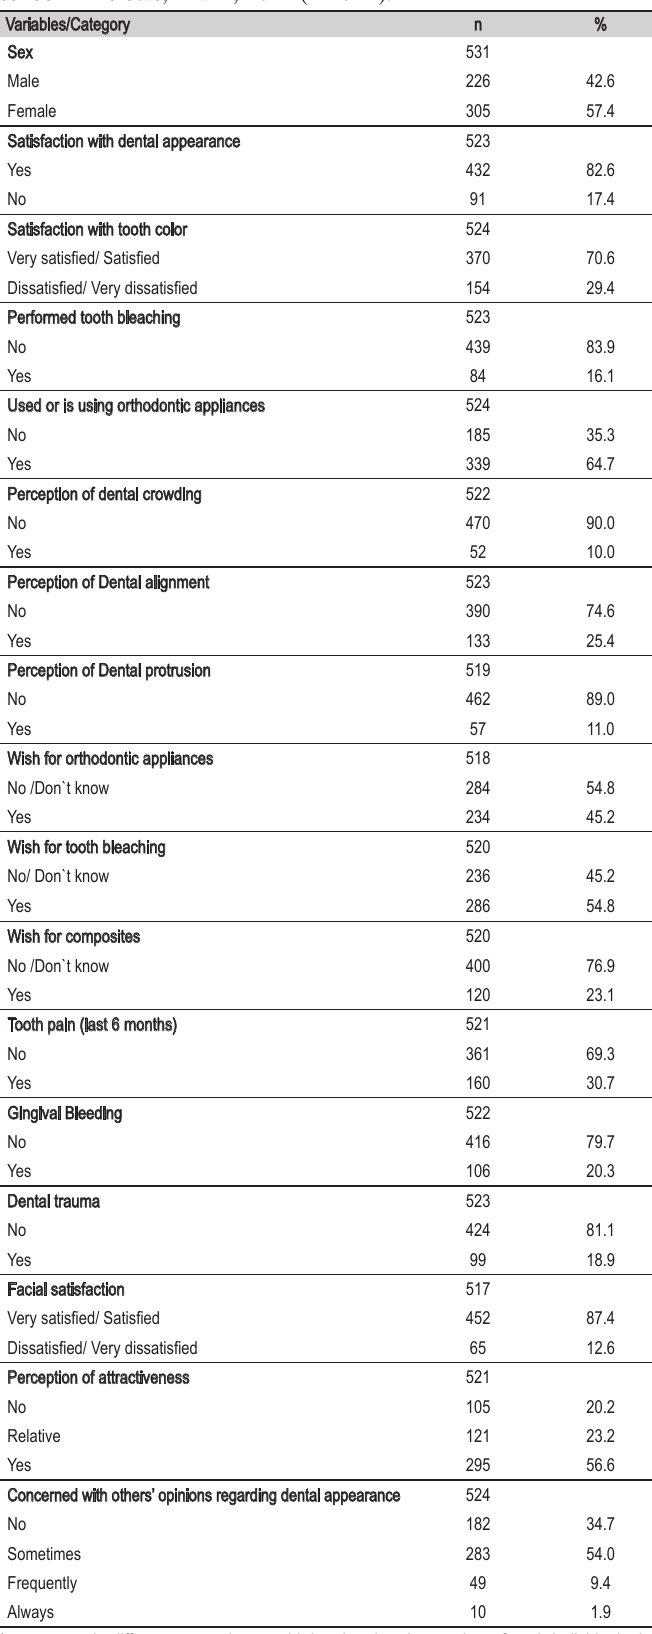
Table 1 - Dental aesthetic perceptions of schoolchildren from a private school in Pelotas, Brazil, 2012